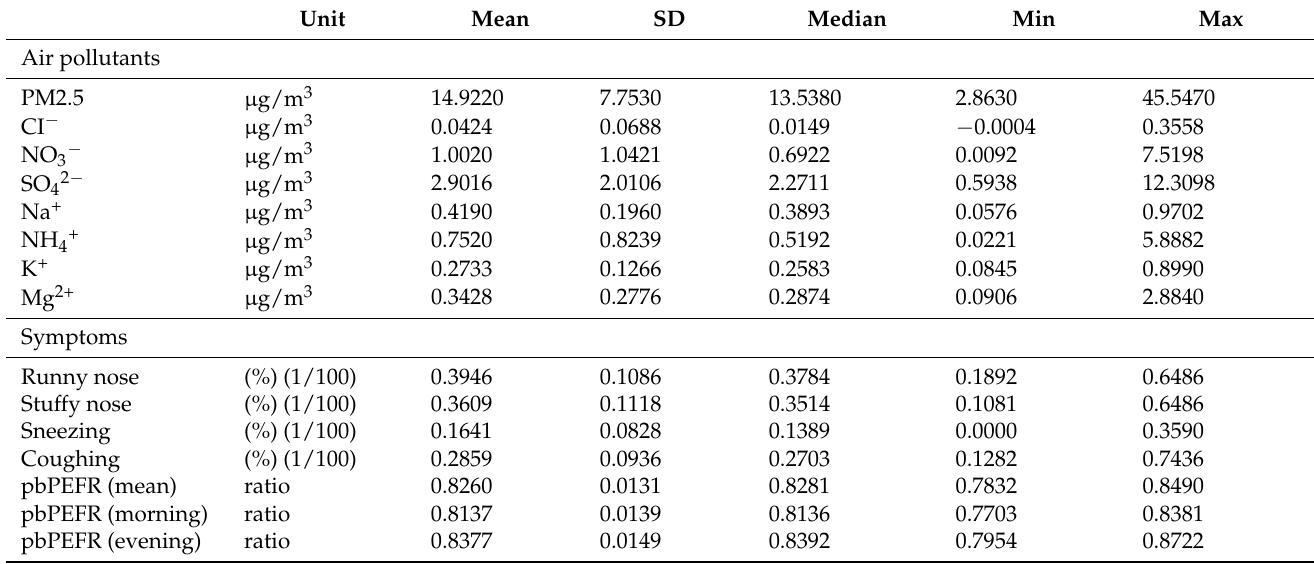
Table 1. Characteristics of concentrations of air pollutants, daily prevalence of respiratory symptoms, and personal best peak expiratory flow rates (pbPEFR).